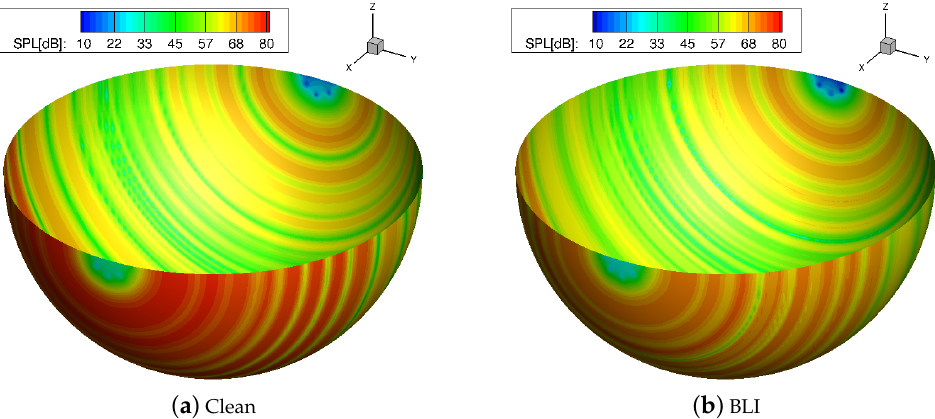
Figure 12. Comparison of direct acoustic field on hemisphere, between the cases without ( a ) and with ( b ) boundary layer ingestion for the frequency 1333 Hz.